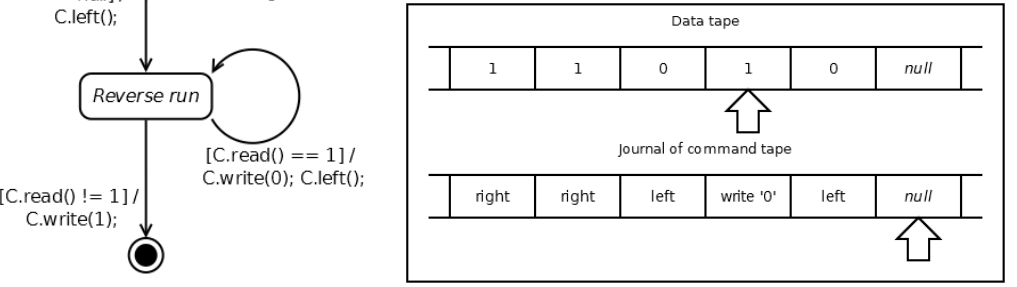
Figure 2. Structure of the control object of automation model of the algorithm of increasing an integer by a unit for Turing